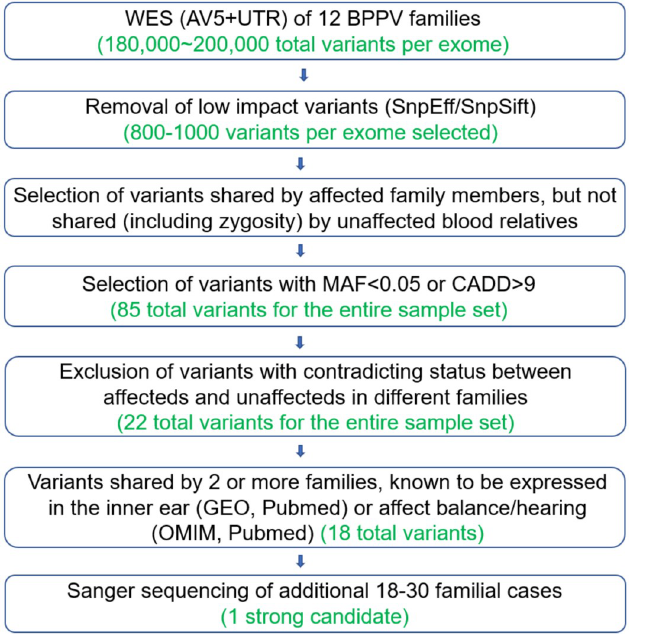
Fig 2. Tiered selection of variants from whole exome sequencing of 12 BPPV